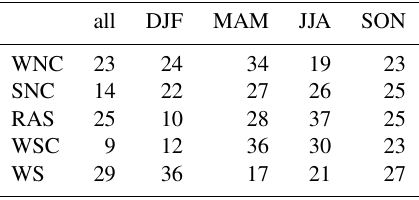
Table 2. Relative frequency of occurrence of the Coggins regimes annually (all) and seasonally (DJF–SON) in the ERA-Interim reanalysis (%). DJF/MAM/JJA/SON correspond to austral sum- mer/autumn/winter/spring respectively. Values for seasons are nor- malized so that rows sum to 100% (not including